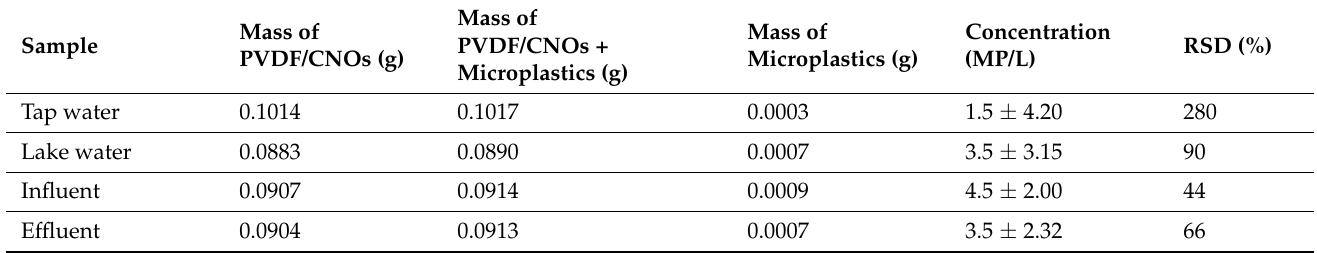
Table 3. Comparison of microplastics concentration removed from wastewater influent by different methods in literature.